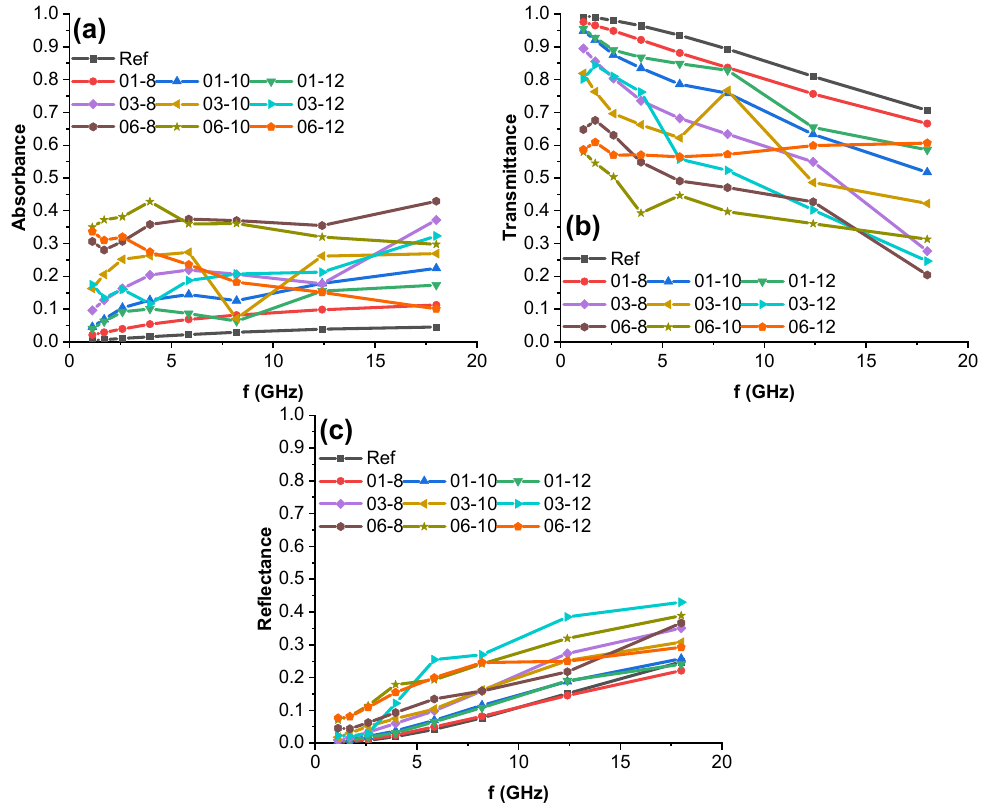
Figure 10. PBS hybrid nanocomposite EM ( a ) absorbance, ( b ) transmittance, and ( c ) reflectance at frequencies from 1.12 to 18 GHz for 1 mm thick samples.